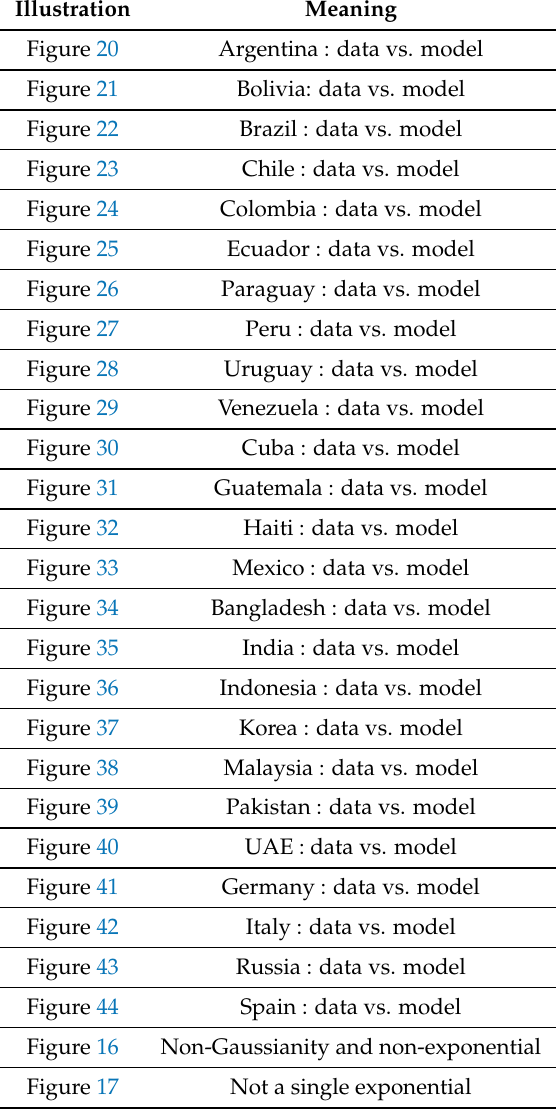
Table 5. List 2 of figures and illustrations. data of active, recovered, deceased (in circle or bar) vs. model of active, recovered, deceased over time. Tracking the number of active cases. Predictive analytics for the next couple days. Illustration Meaning Figure 20 Argentina : data vs. model Figure 21 Bolivia: data vs. model Figure 22 Brazil : data vs. model Figure 23 Chile : data vs. model Figure 24 Colombia : data vs. model Figure 25 Ecuador : data vs. model Figure 26 Paraguay : data vs. model Figure 27 Peru : data vs. model Figure 28 Uruguay : data vs. model Figure 29 Venezuela : data vs. model Figure 30 Cuba : data vs. model Figure 31 Guatemala : data vs. model Figure 32 Haiti : data vs. model Figure 33 Mexico : data vs. model Figure 34 Bangladesh : data vs. model Figure 35 India : data vs. model Figure 36 Indonesia : data vs. model Figure 37 Korea : data vs. model Figure 38 Malaysia : data vs. model Figure 39 Pakistan : data vs. model Figure 40 UAE : data vs. model Figure 41 Germany : data vs. model Figure 42 Italy : data vs. model Figure 43 Russia : data vs. model Figure 44 Spain : data vs. model Figure 16 Non-Gaussianity and non-exponential Figure 17 Not a single